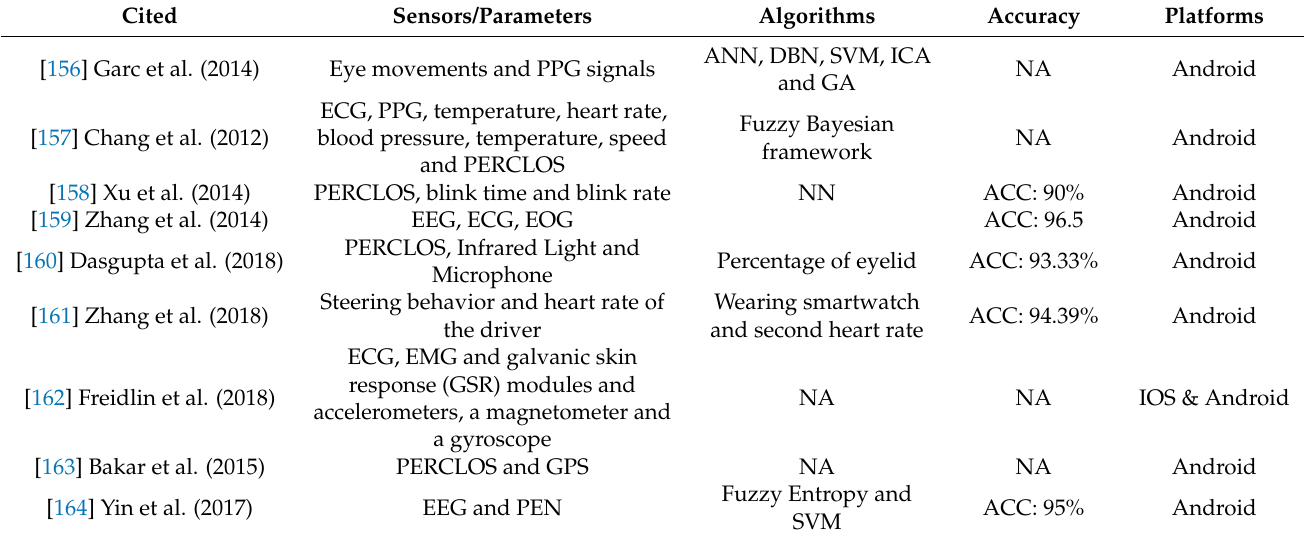
Table 2. State-of-the-art DFD systems used smartphone-based architecture by machine learning algorithms.